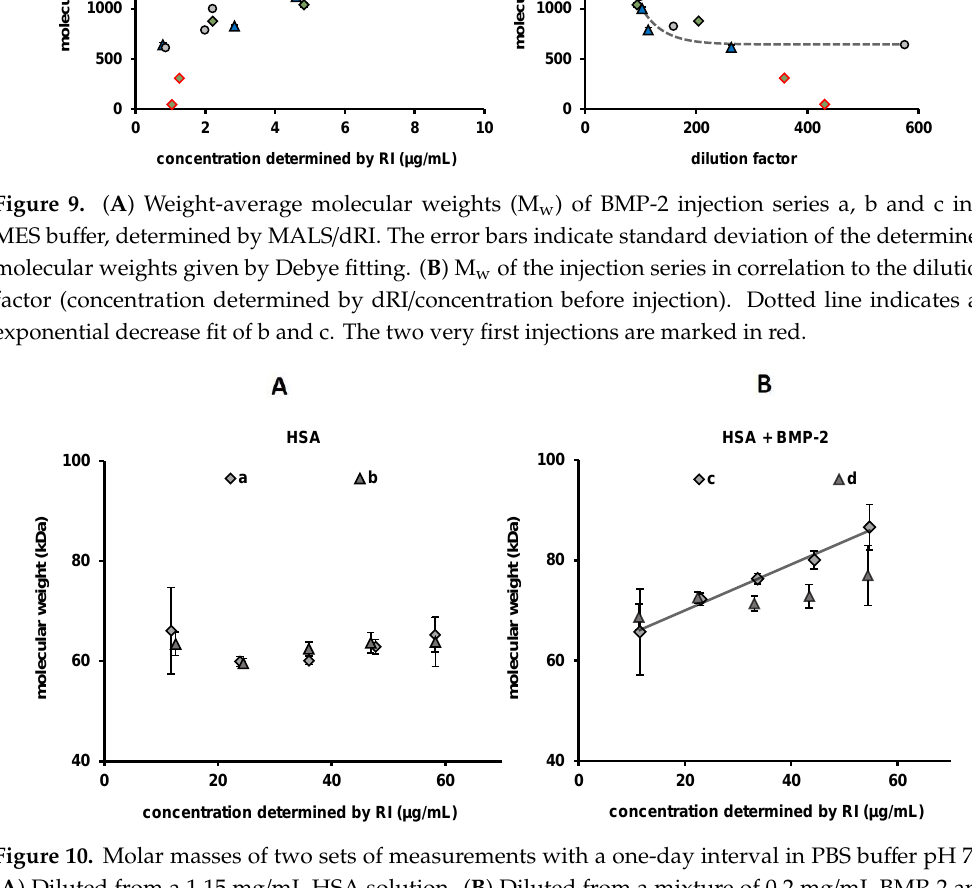
Figure 10. Molar masses of two sets of measurements with a one-day interval in PBS buffer pH 7.4. ( A ) Diluted from a 1.15 mg/mL HSA solution. ( B ) Diluted from a mixture of 0.2 mg/mL BMP-2 and